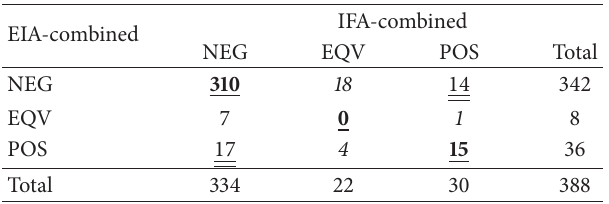
Table 4: Comparison between combined ANA immunoassay (Pha- dia) and HEp-2000 cell immunofluorescence (Immuno Concept).